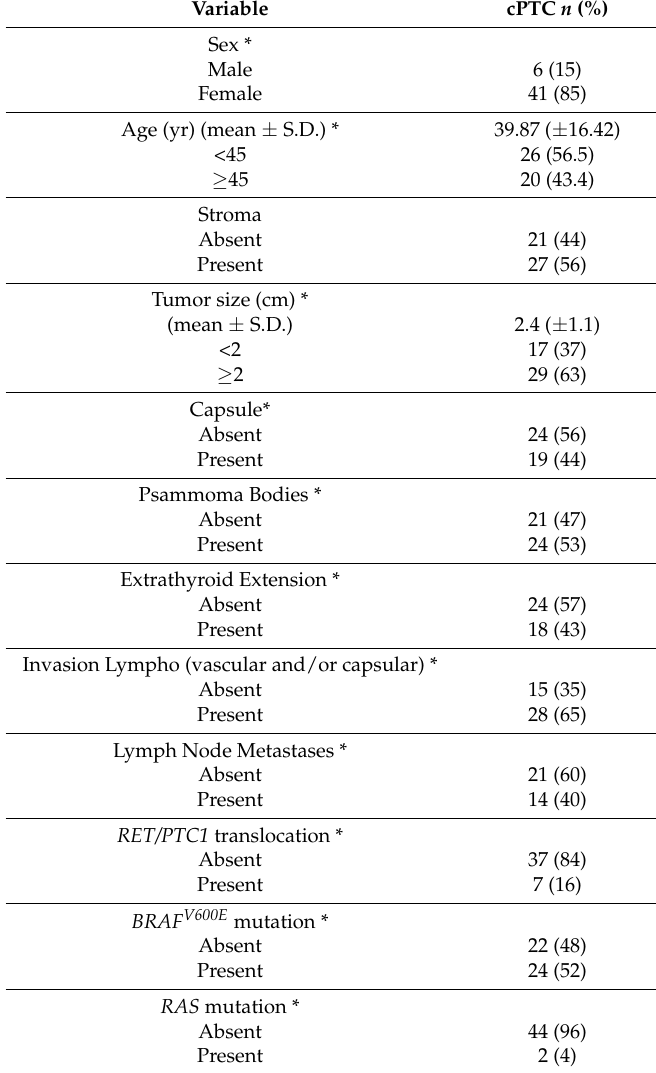
Table 1. Summary of the clinical, pathological, and molecular data of the cPTC